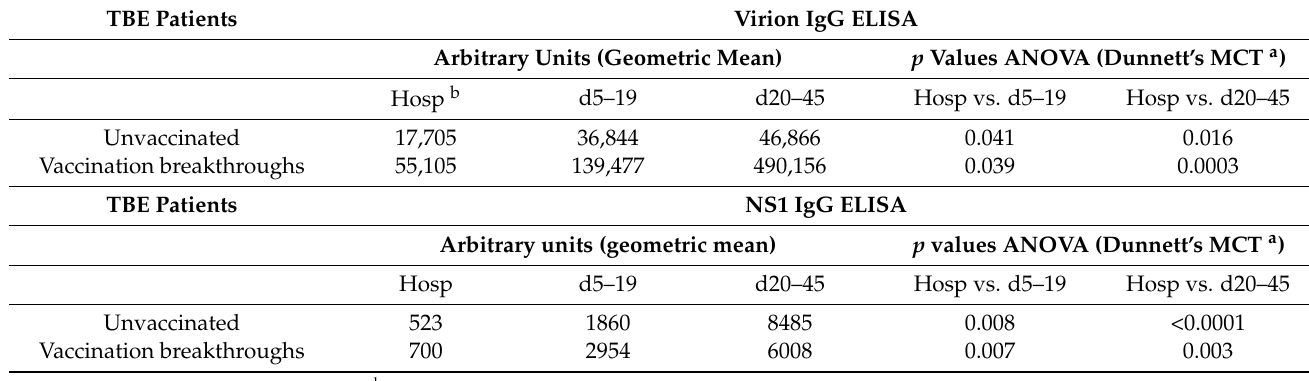
Table 3. Statistical evaluation of the increase in the mean TBE virion- and NS1-specific IgG antibody responses at different time points after hospitalization (Figure